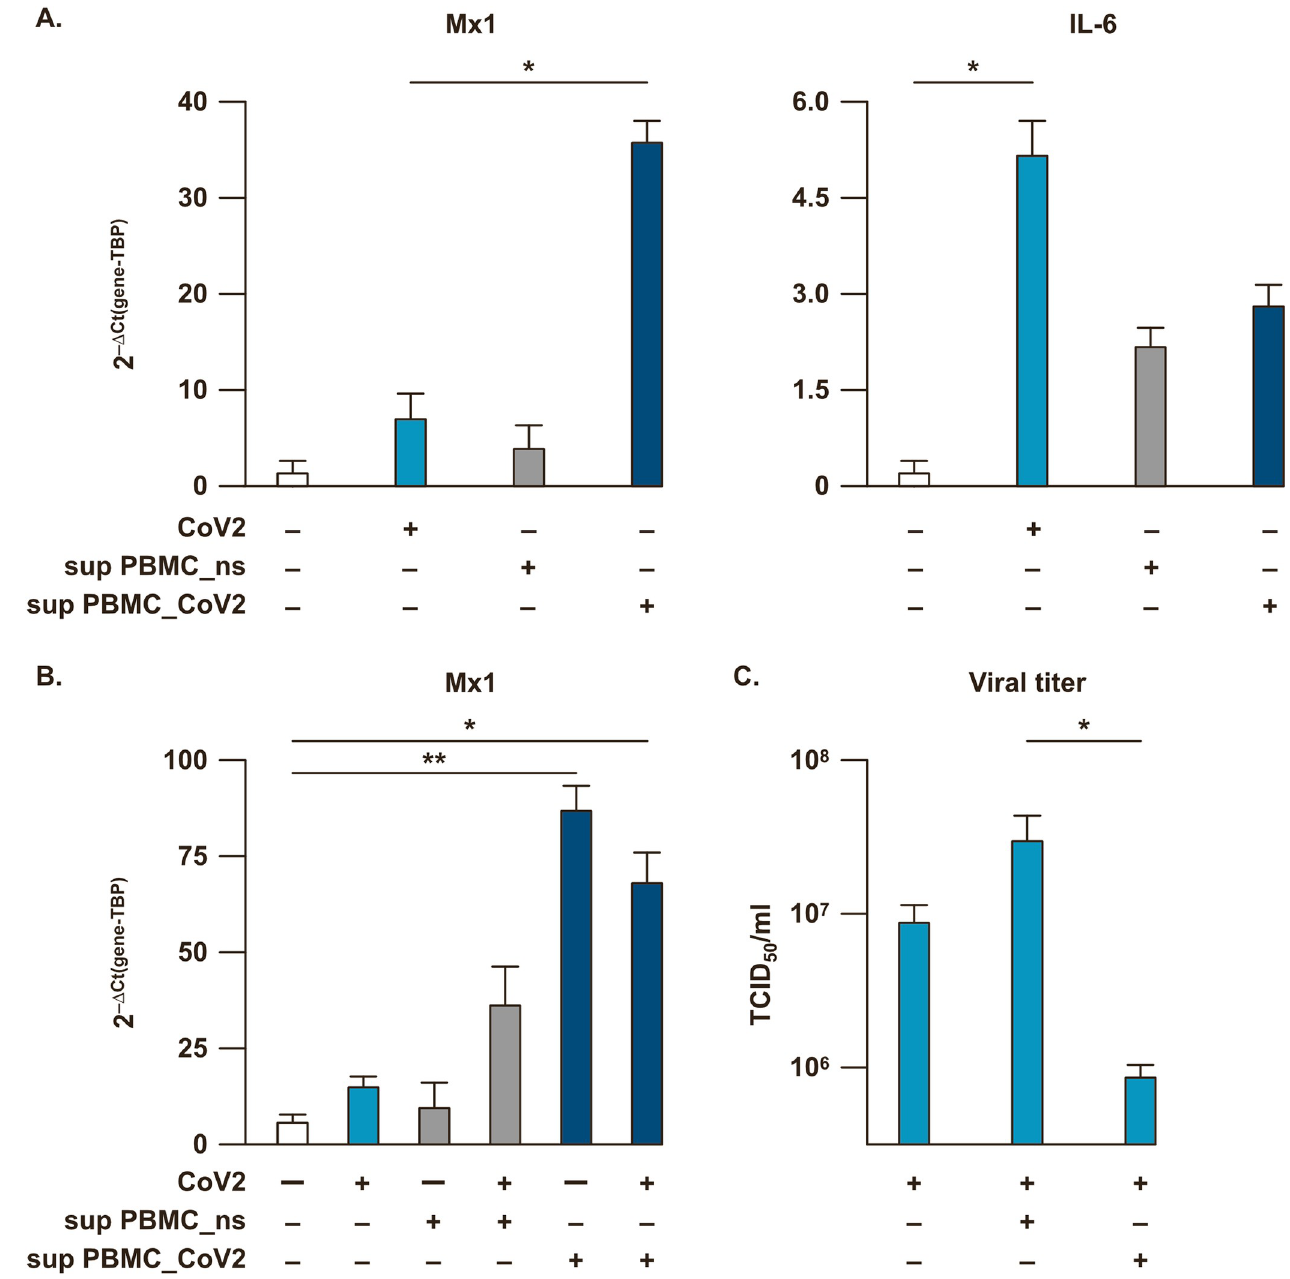
Fig 3. Type I IFN-induced anti-viral state impacts on SARS-CoV-2 infected Calu-3 lung epithelial cell line. ( A ) The human lung epithelial cell line Calu-3 was left untreated (not stimulated, ns), infected for 24 hours with SARS-CoV-2 at the back titration dose calculated in peripheral blood mononuclear cells (PBMC) (10 4 TCID 50 /ml for 0.02 MOI) or treated with 24 hour-supernatants collected from either ns PBMC cultures (sup PBMC_ns) or from SARS-CoV-2 (MOI = 0.02)-treated PBMC cultures (sup PBMC_CoV2). Relative expression of Mx1 and IL-6 genes was measured by quantitative real time PCR analysis. All quantification data were normalized to TBP level by using the equation 2 - Δ Ct . ( B ) Calu-3 cell line was infected with SARS-CoV-2 at the back titrated dose calculated in PBMC (10 4 TCID 50 /ml for 0.02 MOI) in presence of 24 hour-supernatants collected from either ns PBMC cultures (sup PBMC_ns) or from SARS-CoV-2 (MOI = 0.02)-treated PBMC cultures (sup PBMC_CoV2). Mx1 gene expression was quantified by real time PCR and quantification data normalized to TBP level by using the equation 2 - Δ Ct . ( C ) Virus titers were evaluated in supernatants from infected Calu-3 cultures described in ( B ) by Endpoint Dilution Assay by using the Reed-Muench formula and reported as TCID 50 /ml. Shown results were mean relative values ± SEM of 3 independent experiments. P-values were depicted as follows: � p � 0.05; �� p �